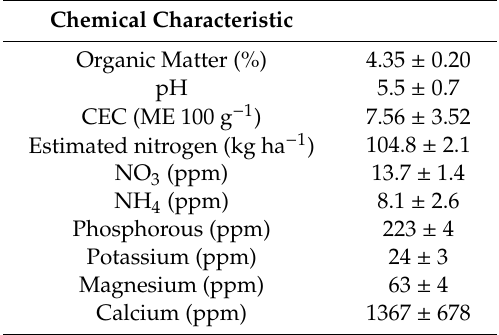
Table 1. Mean ± SE of initial soil parameters using Mehlich III extraction averaged across the four